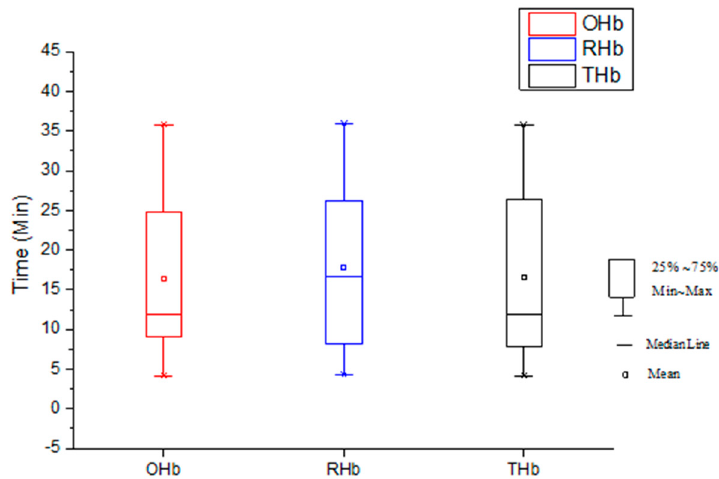
Figure 7. Drug (APO) Response Time. (* RHb: deoxy-hemoglobin, OHb: oxy-hemoglobin, THb: total